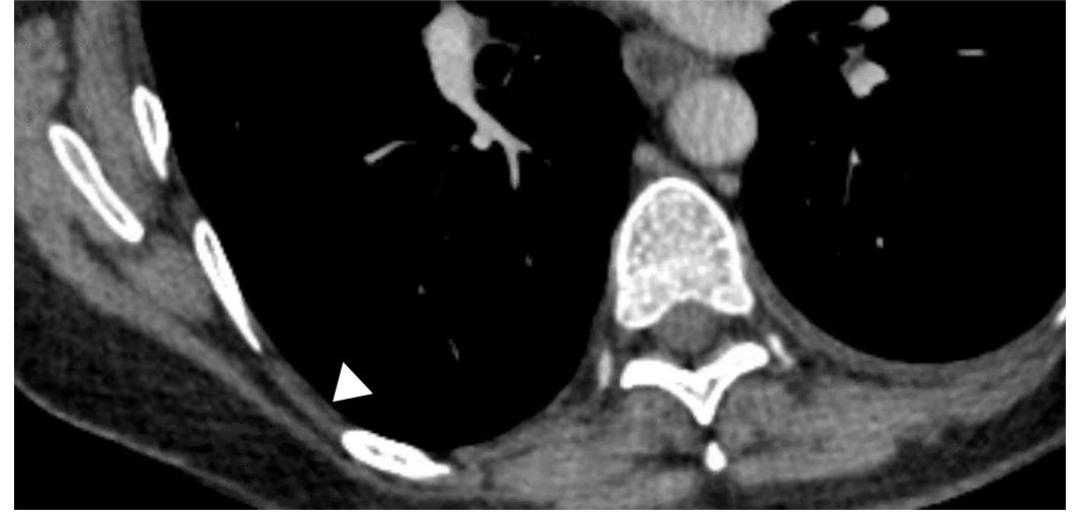
Figure 7. CT appearances of the “pleural stripe”; (white arrow head)